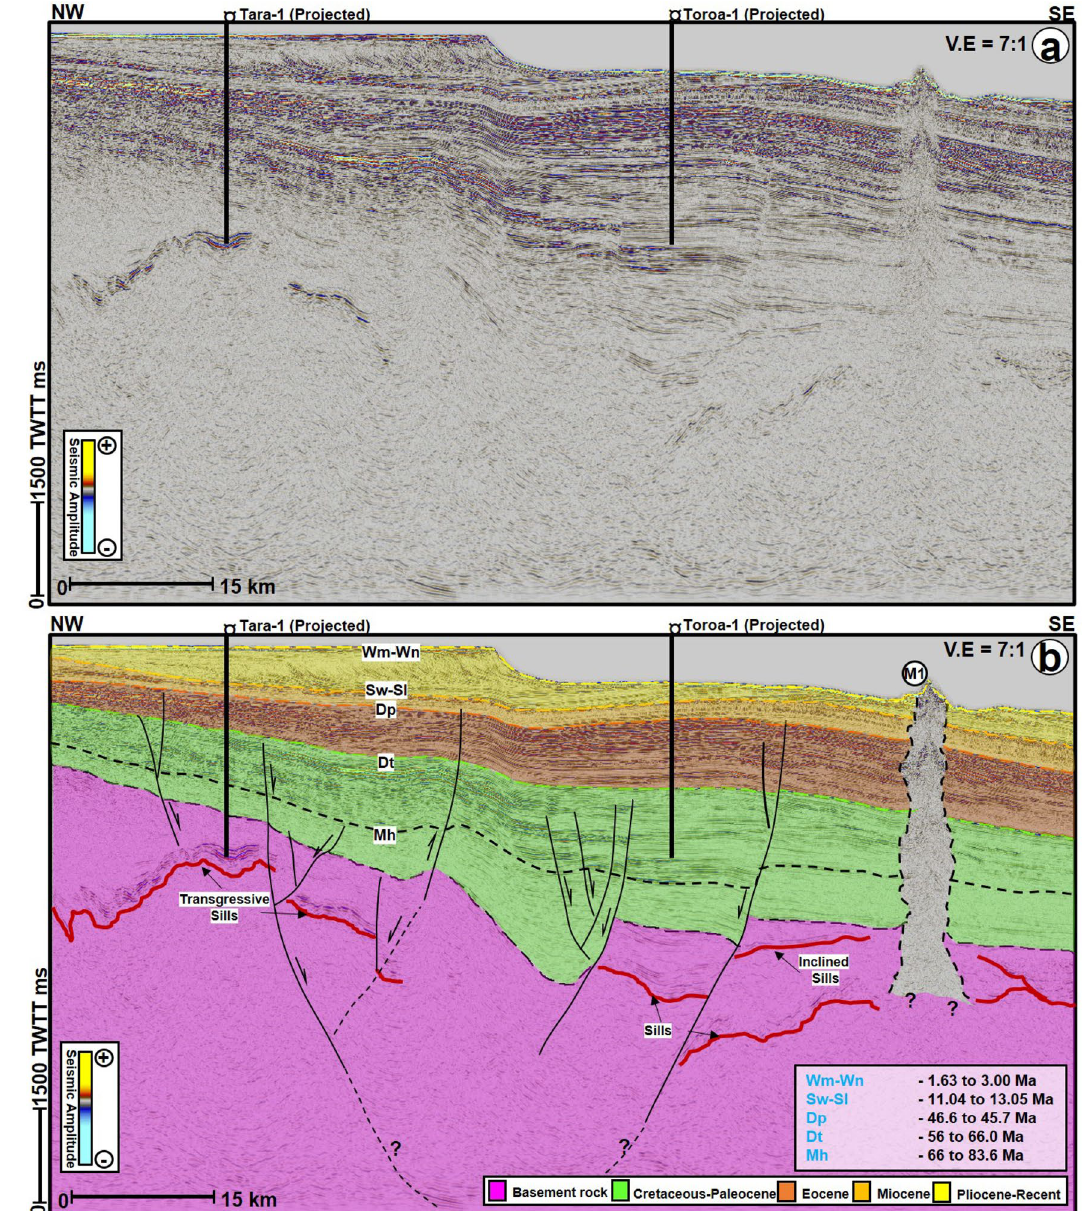
Figure 3. Uninterpreted ( a ) and interpreted ( b ) NW–SE seismic profiles showing the link between mound M1, its underlying fluid escape pipe, intrusive rocks, and the basement rocks of the study area. Intrusive rocks or magmatic sills are highlighted in red color within the basement unit in (3b). TWTT: Two-way travel time in